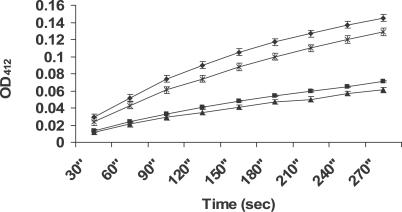
Metronidazole Binding Diminishes Thioredoxin Reductase Activity of recEh TrxRAfter expression of recEH TrxR and recEH Trx in the presence or absence of metronidazole for 3 h, proteins were isolated and thioredoxin reductase activity of recEh TrxR was determined by reduction of DTNB via recEh Trx as measured at λ = 412 nm (OD412). Diamonds (♦) indicate the use of unmodified forms of both recEh TrxR and recEh Trx, crosses (x) the use of unmodified recEH TrxR and metronidazole-modified recEh Trx. Squares () indicate the use of metronidazole-modified recEh TrxR and unmodified recEh Trx, and triangles (▴) the use of modified forms of both recEh TrxR and recEh Trx.